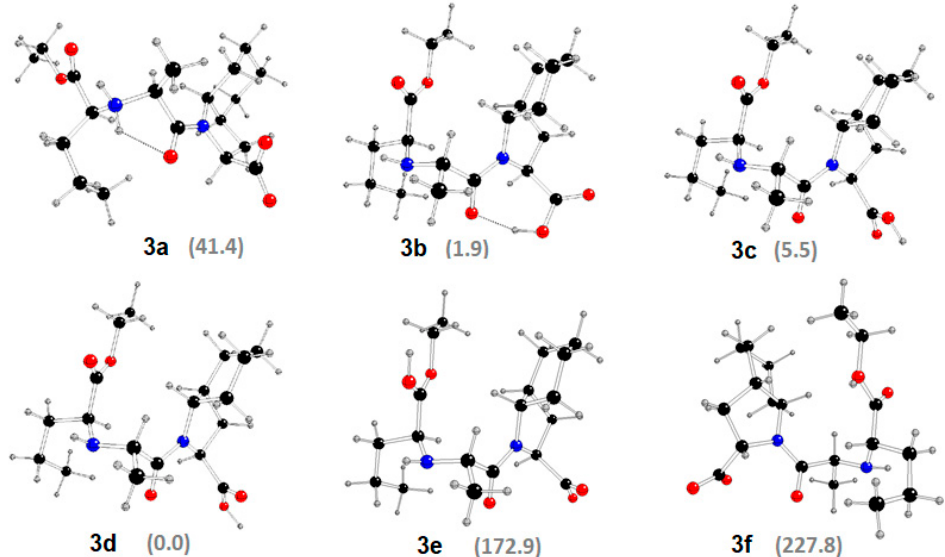
Figure 5. Optimized geometry of protonated IVEGIA, structure 3 with corresponding relative Gibbs free energies at 298 K (in kJ / mol) in parentheses (see Figure 3 for atom notations).